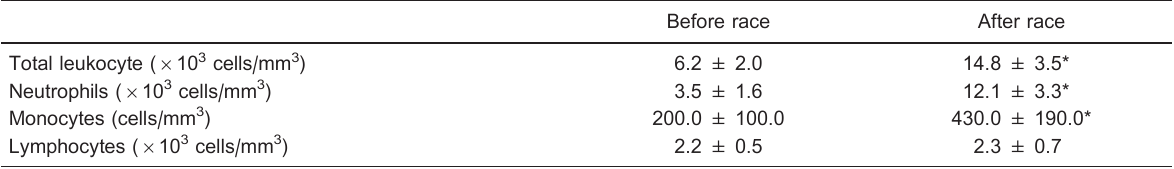
Table 2. Adventure sprint race increased total leukocyte, neutrophil and monocyte but not lymphocyte counts. Before race After race